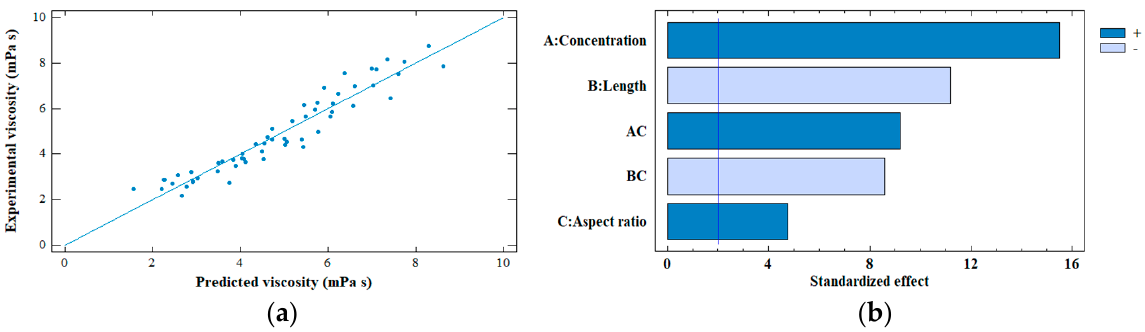
Figure 4. ( a ) Predicted viscosity versus experimental viscosity, and ( b ) Standardized Pareto chart for the viscosity of CNF dispersions. AC: Concentration-Length interaction, and BC: Length-Aspect ratio interaction.